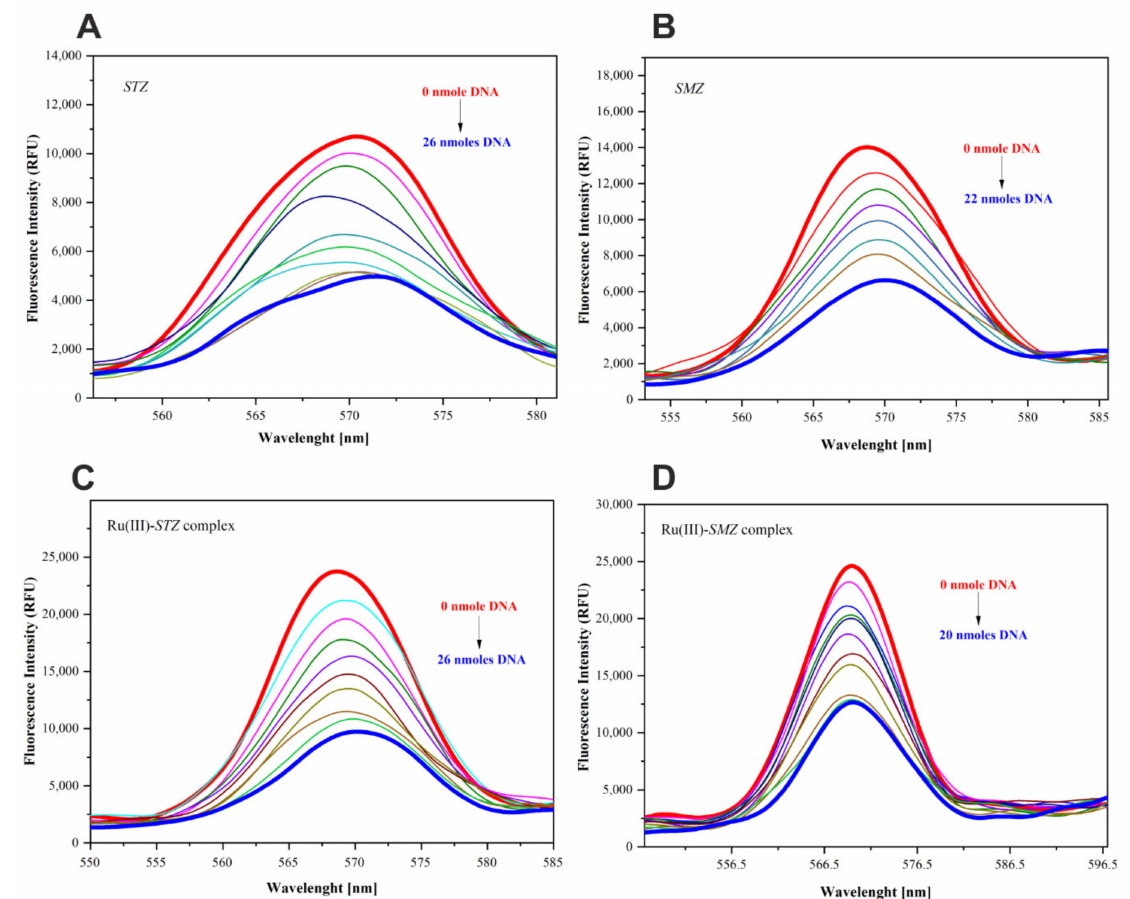
Figure 5. Changes observed in fluorescence emission spectra of ( A ) SMZ (18 µ M), ( B ) STZ (24 µ M), ( C ) Ru(III)-SMZ complex (69 µ M), and ( D ) Ru(III)-STZ complex (146 µ M), with increasing of CT -DNA given in nmoles, ( λ exc = 260 nm, λ em = 570